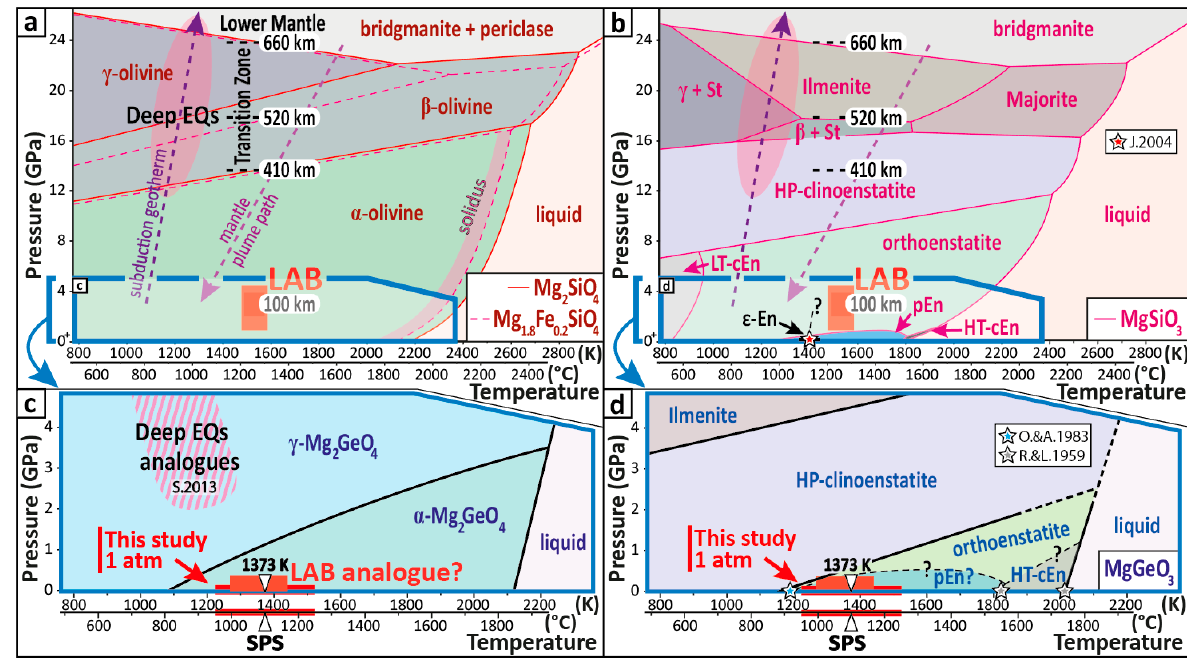
Figure 2. Comparison of (Mg,Fe) 2 SiO 4 ( a ) and MgSiO 3 ( b ) with their analogues Mg 2 GeO 4 ( c ) and MgGeO 3 ( d ). ( a ) Phase diagram of Mg 2 SiO 4 and (Mg 0.9 Fe 0.1 ) 2 SiO 4 (San Carlos olivine) adapted from [60]. The latter composition corresponds to the San Carlos olivine, extensively studied and considered as representative of the composition of the entire upper mantle. The main discontinuities in the mantle are (1) the lithosphere–asthenosphere boundary (LAB) at an average depth of ≈ 100 km, (2) the α - β transition at ≈ 410 km, the β - γ transition at ≈ 520 km and (4) 660-km discontinuity, i.e., top of the Lower Mantle. ( b ) Phase diagram of MgSiO 3 (natural enstatite) [60]. ( c ) Phase diagram of Mg 2 GeO 4 (adapted from [76] and [53]) showing the P-T-conditions for deep earthquakes analogues and the P-T range investigated in this study, which may correspond to an analogue of the LAB. ( d ) Phase diagram of MgGeO 3 (adapted from [54]) showing the P-T range investigated in this study and the expected stability fields of unquenchable protoenstatite (pEn) and high-T clinoenstatite (HT-cEn). The white cursors indicate the sintering conditions (1100 °C = 1373 K, see text, Figure S1 and Section 3). Legend: St = stishovite; LT-cEn = Low-T clinoenstatite; HT-cEN = High-T clinoenstatite; pEn = protoenstatite; References: O.&A.1983 =